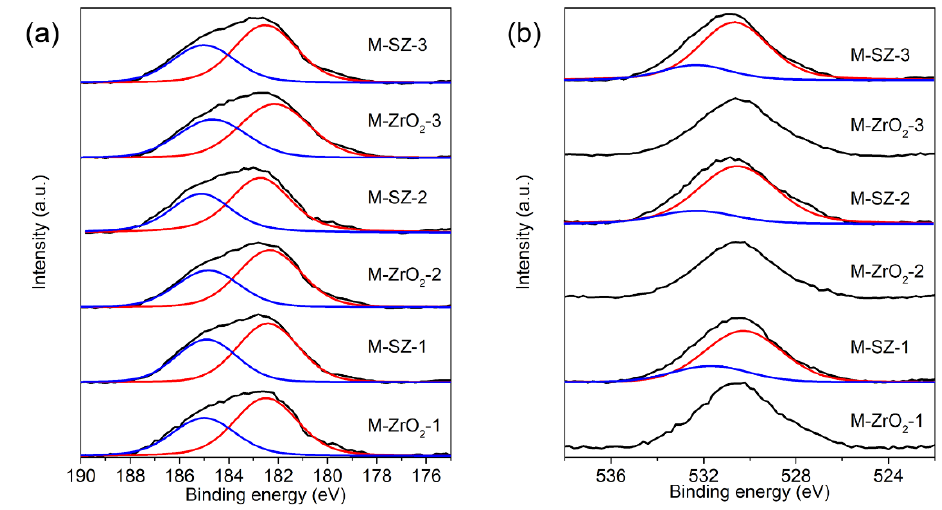
Figure 2. ( a ) Zr 3d and ( b ) O 1s XPS spectra of M-ZrO 2 -1, M-ZrO 2 -2, M-ZrO 2 -3, M-SZ-1, M-SZ-2, and M-SZ-3.